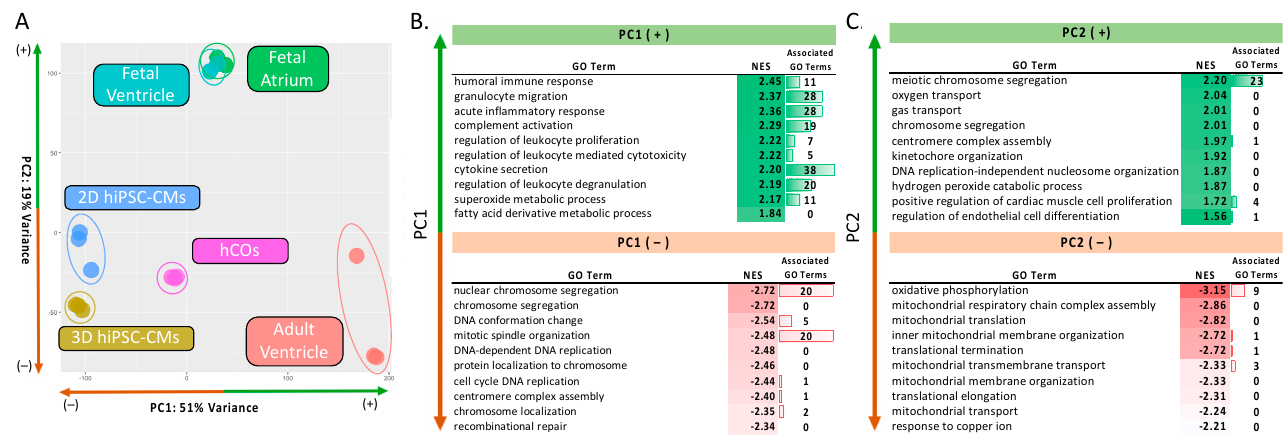
Figure 4. PCA and GSEA analysis of in vitro and human myocardium samples ( A ) PCA analysis of 2D hiPSC-CMs ( n = 3), 3D hiPSC-CMs ( n = 3), hCOs ( n = 3), fetal atrium ( n = 2), fetal ventricle ( n = 2) and adult ventricle ( n = 3) samples. ( B ) GSEA analysis performed using the gene loadings from PC1. Data show 10 significantly enriched GO terms. Associated GO terms depict redundant GO terms removed through REViGO analysis. PC1(+) (top) depicted pathways enriched in adult ventricles; PC1(–) (bottom) depicts pathways enriched in in vitro monocellular iPSC-CM c ( C ) 10 significant enriched GO terms after applying GSEA to PC2. PC2(+) (top) represents pathways enriched in fetal myocardium; PC2(–) (bottom) represents pathways enriched in non-fetal myocardium samples.